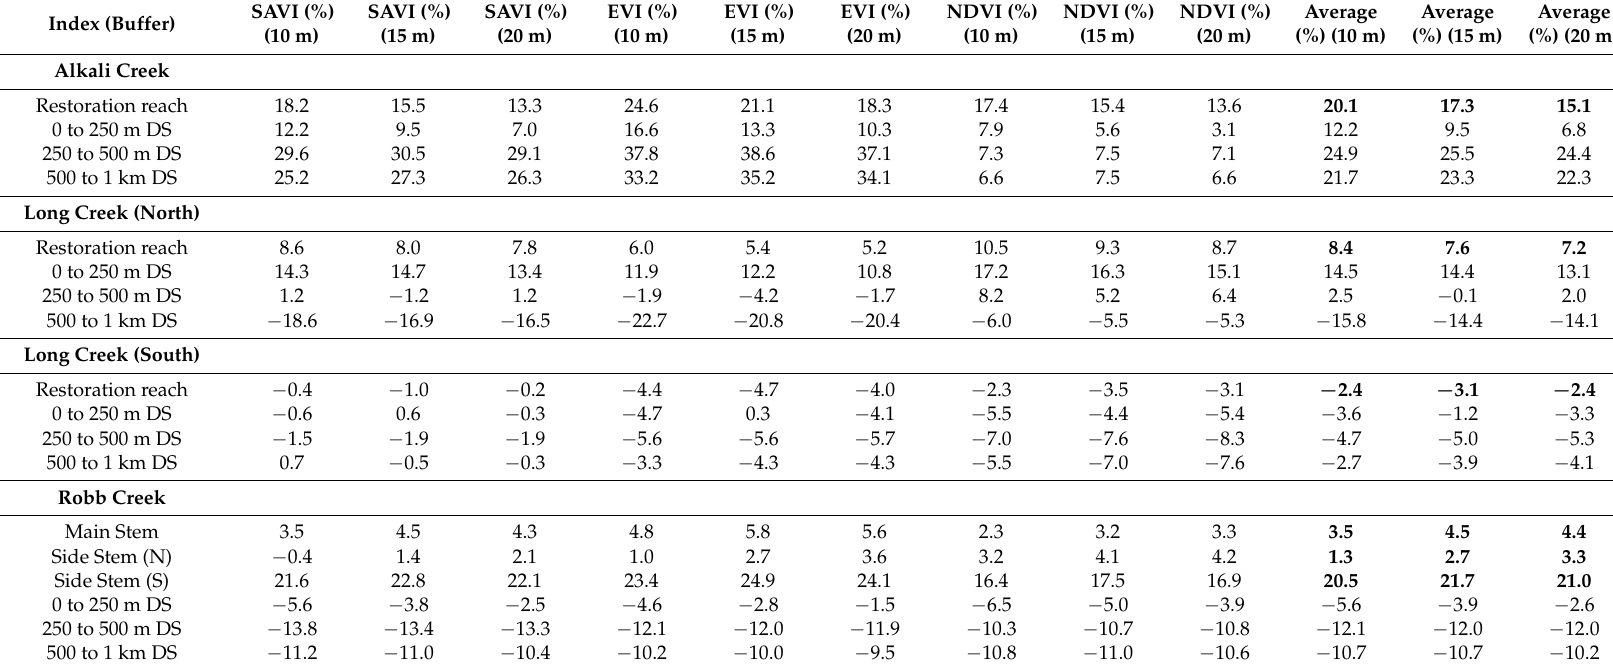
Table 5. Percent change in riparian greenness between pre- (2014) and post-restoration (2017) images after controlling for between-image differences in greenness not related to the restoration action. Greenness was evaluated using the Soil-Adjusted Vegetation Index (SAVI), Enhanced Vegetation Index (EVI) and Normalized Difference Vegetation Index (NDVI). Indices were evaluated using a 10 m, 15 m, and 20 m buffer from the stream. Changes along the restored reaches are in bold. DS: downstream; N: North; S: